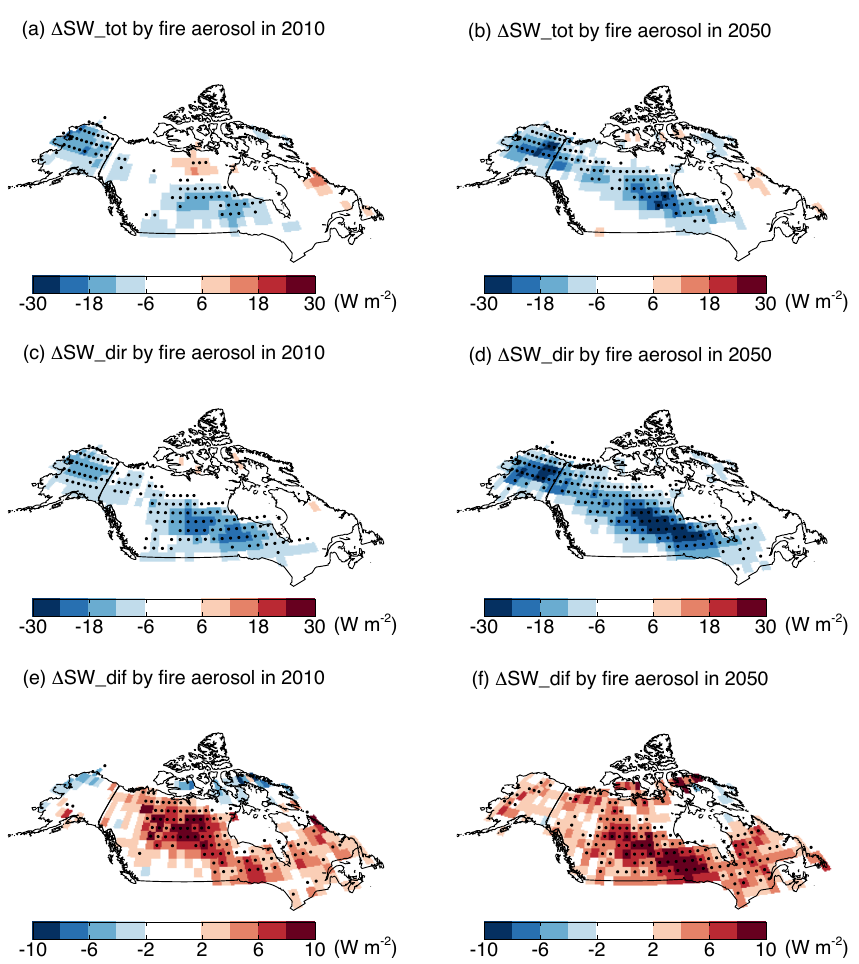
Figure 9. Changes in surface radiative fluxes induced by wildfire aerosols in boreal North America. Results shown are for the changes in summertime (June–August) (a, b) total, (c, d) direct, and (e, f) diffuse solar radiation at surface caused by aerosols from wildfire emissions at (a, c, e) present day and (b, d, f) mid-century. Significant changes ( p < 0 . 05) are marked with black dots. Results for 2010 are